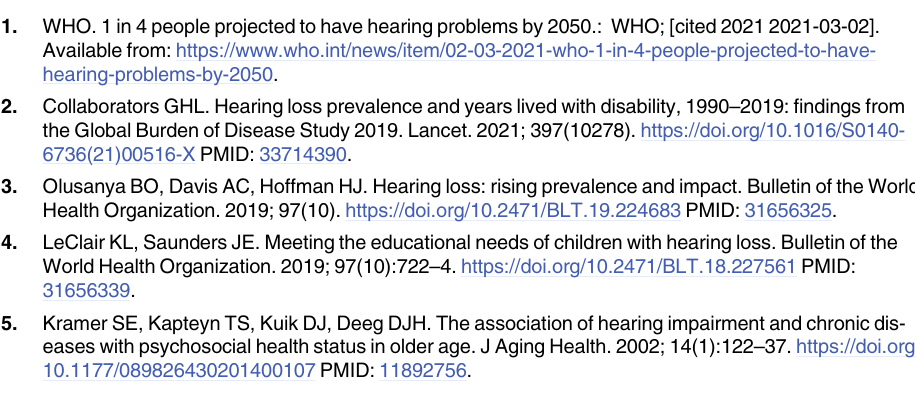
S1 Table. PRISMA 2020 checklist. S2 Table. Detailed search strategy. S1 Fig. Funnel plot with included 18